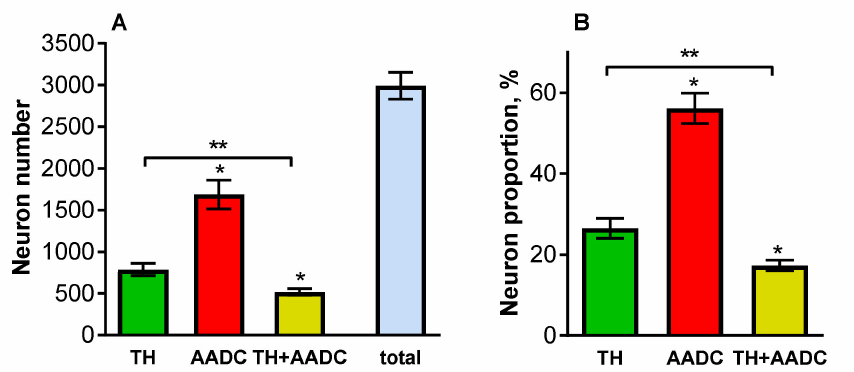
Figure 6. Quantification of neurons in the periventricular nucleus (PeVN), immunopositive for tyro- sine hydroxylase (TH) only, aromatic L-amino acid decarboxylase (AADC) only, and both dopamine- synthesizing enzymes—TH and AADC. ( A ). The number of neurons in each of the populations of immunopositive neurons and the total number of all immunopositive neurons; ( B ). The proportion of each of the populations of immunopositive neurons in relation to the total number of immunopositive neurons, taken as 100%. * p < 0.05, significant differences between the previous and subsequent neuron populations; ** p < 0.05, significant differences between the selected neuron